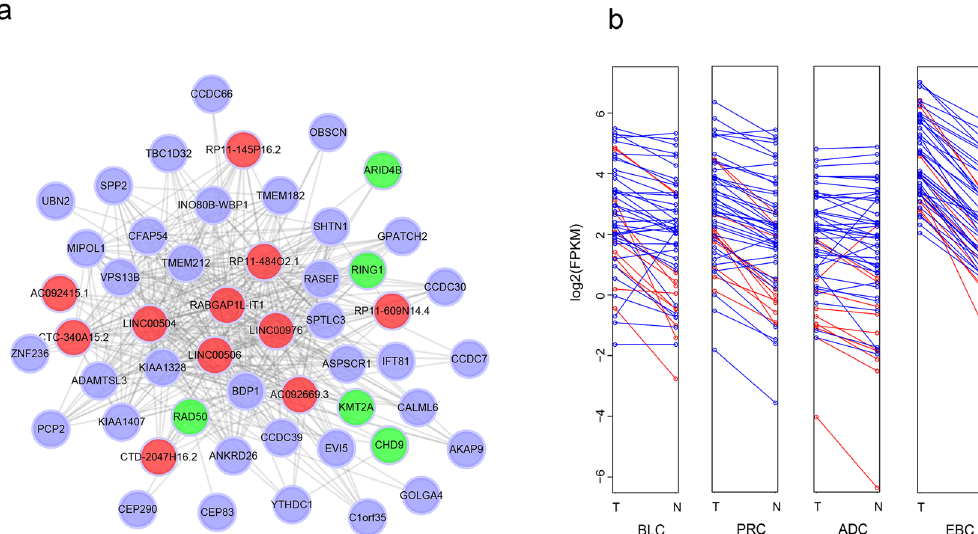
Figure 5. Network and expression levels of 51 top hub genes in brown module. ( a ) Cytoscape network visualization of 51 genes, in which only edges with weight ( w ) above a threshold of 0.2 are displayed. The red nodes denote lncRNA genes. The green and blue nodes both denote protein-coding genes, but the green color stands for genes with function in maintaining genomic stability. ( b ) The expression levels of 51 genes in each cancer type. The y axis represents the average FPKM value of samples in each group. And the blue and red colors denote protein-coding genes and onco-lncRNAs,